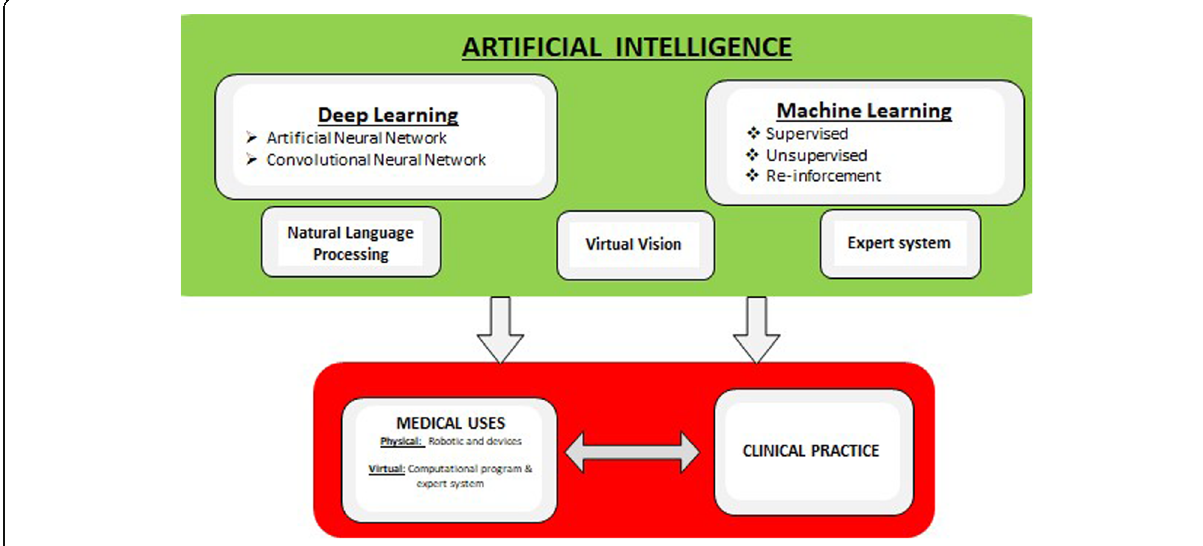
Fig. 2 Components of artificial intelligence and use in the medical